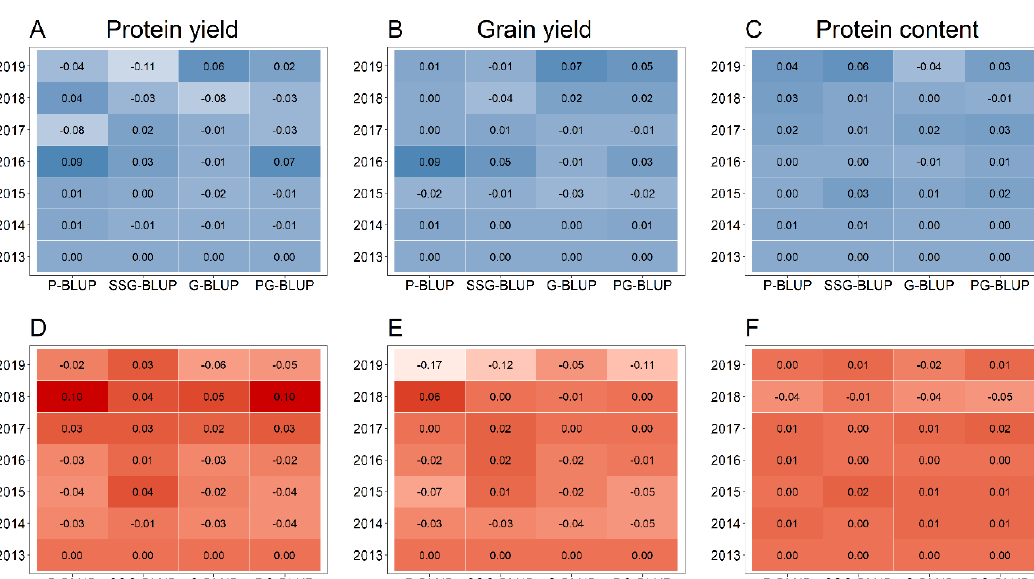
Figure 6. Number of lines tested in preliminary yield trials (PYT), in the respective validation populations (VP) and training population size without (TP small ) or with augmentation of lines tested in all preliminary yield trials preceding a validation year (TP large ) in combination without including pre-existing information of a specific validation population from the preliminary yield trial preceding the validation year (“Based”-predictions) or with including this source of phenotypic information into the training population (“Assisted”-predictions).